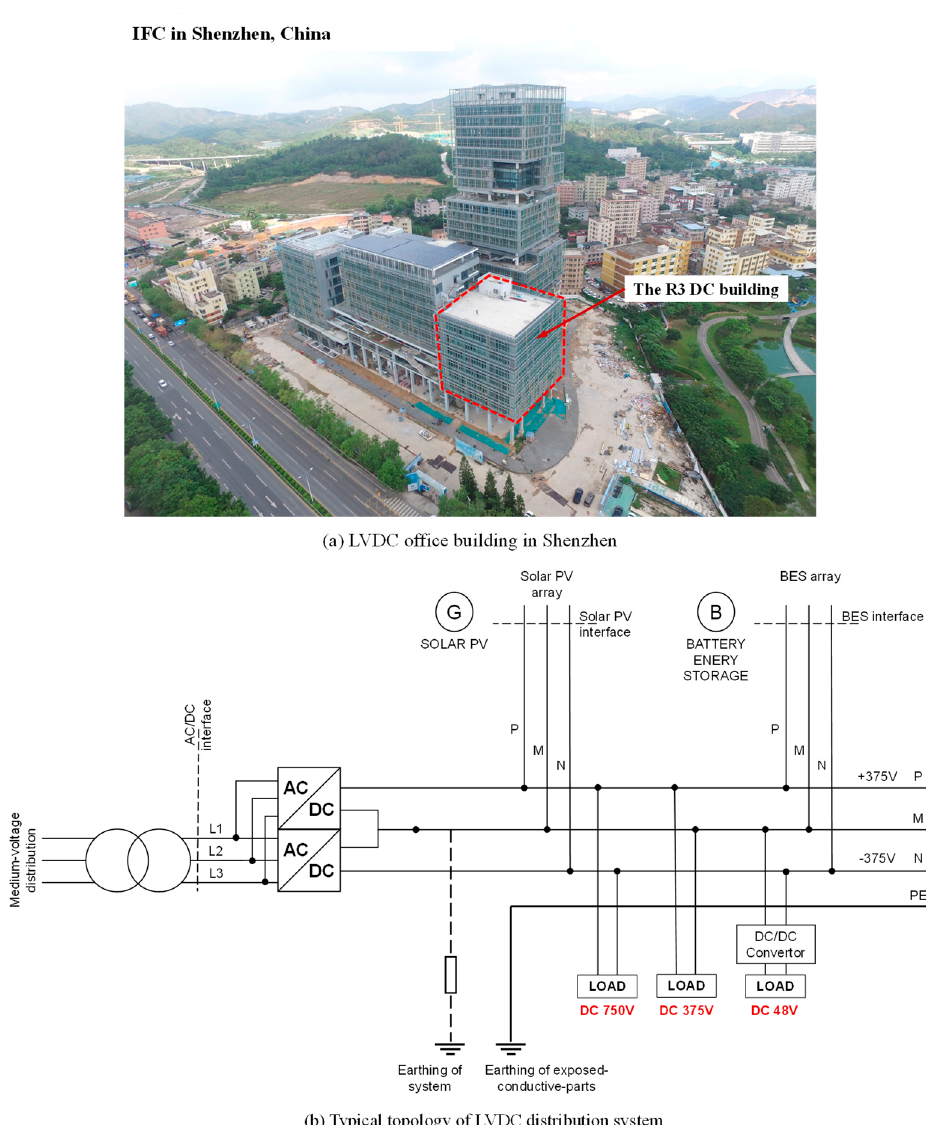
Figure 3. Application of LVDC technology in a typical office building.